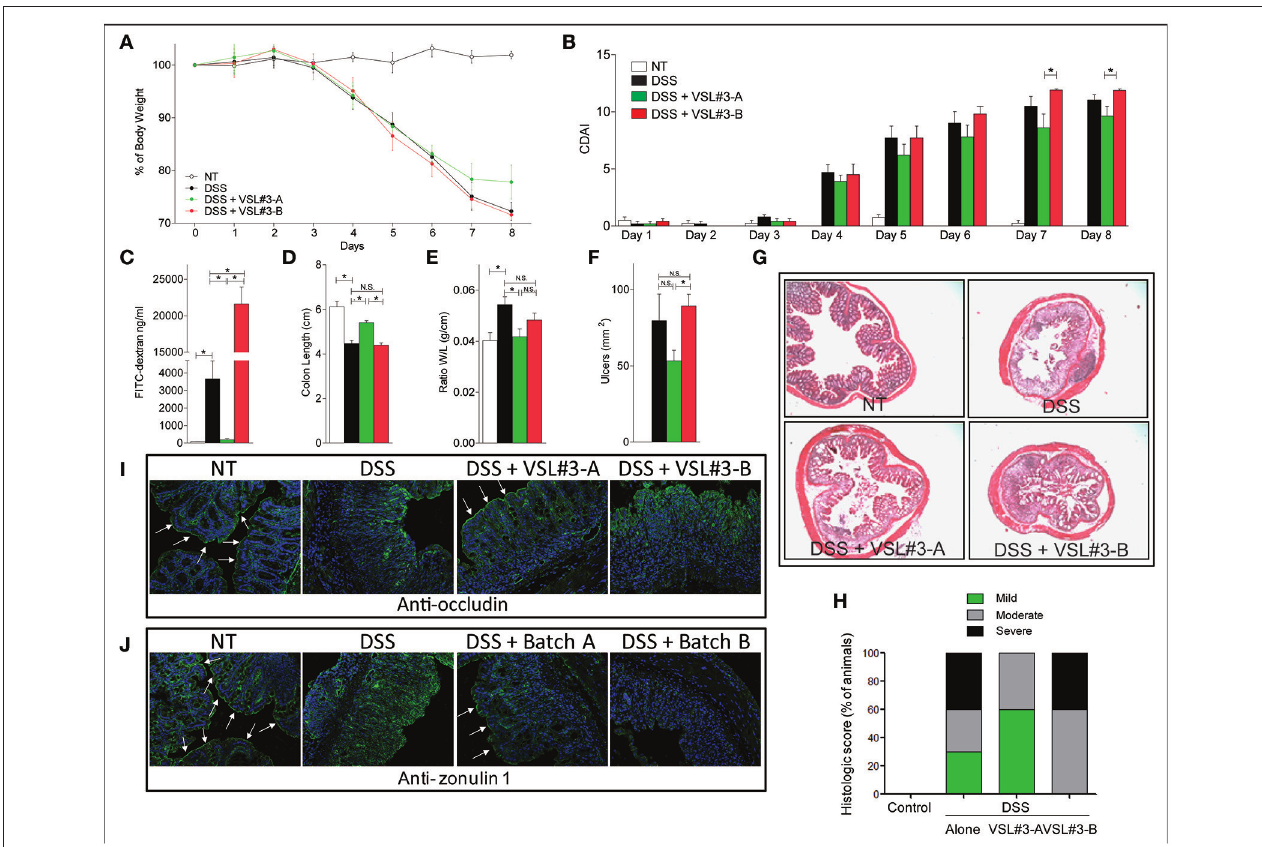
FIGURE 1 | Effects of VSL#3 on DSS colitis. Mice were treated with DSS in drinking water and then administered with vehicle or one of the two formulations of VSL#3 by gavage from day 0 to day 8. VSL#3-A attenuated the development of wasting disease, i.e., change in body weight (A) and CDAI score (B) . VSL#3-B worsens of intestinal permeability: FITC dextran (C) . (D–F) Only VSL#3-A reduced intestinal inflammatory score: colon length (D) , ratio between colon weight and colon length (E) , and ulcers area (F) . H&E staining on colon sections (G) and analysis of histological score (H) of control, DSS treated and DSS plus one of the two formulations of VSL#3 (magnification 10x). Representative immunohistochemistry of colon with anti-occludin (I) and anti-zonulin1 (J) antibody for each experimental group. Results are the mean ± SEM of 4–6 mice per group (* P < 0.05).